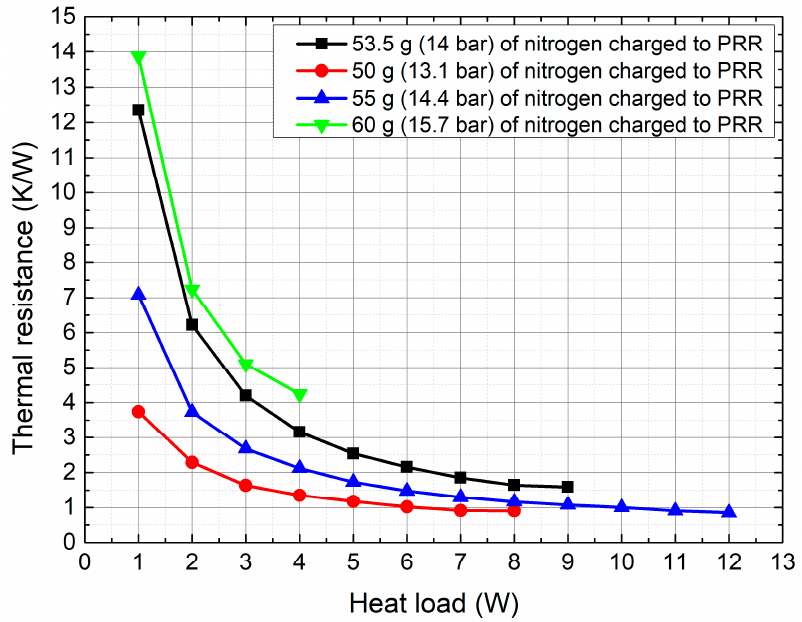
Figure 14. Thermal resistance of the CLHP according to the heat load.